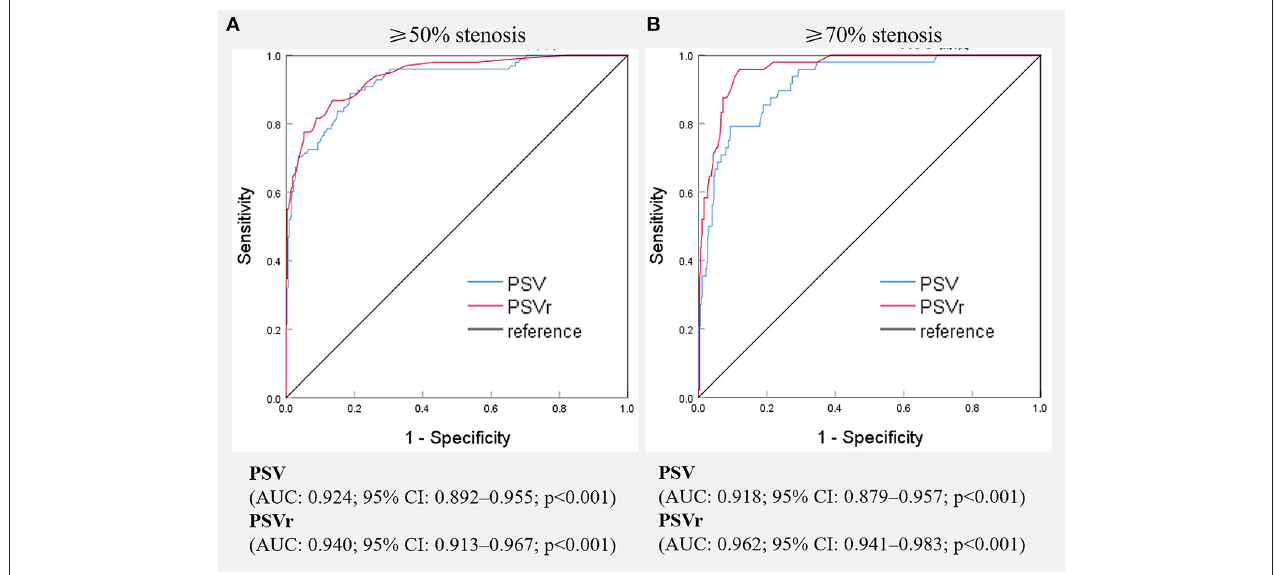
FIGURE 3 | Receiver operating characteristic curves of various hemodynamic parameters for the evaluation of ≥ 50% (A) and ≥ 70% (B) stenosis of the subclavian artery. PSV, peak systolic velocity; PSVr, the ratio of peak systolic velocity at the stenotic segment to that at the distal segment; AUC, area under receiver operating characteristic curve, CI, confidence